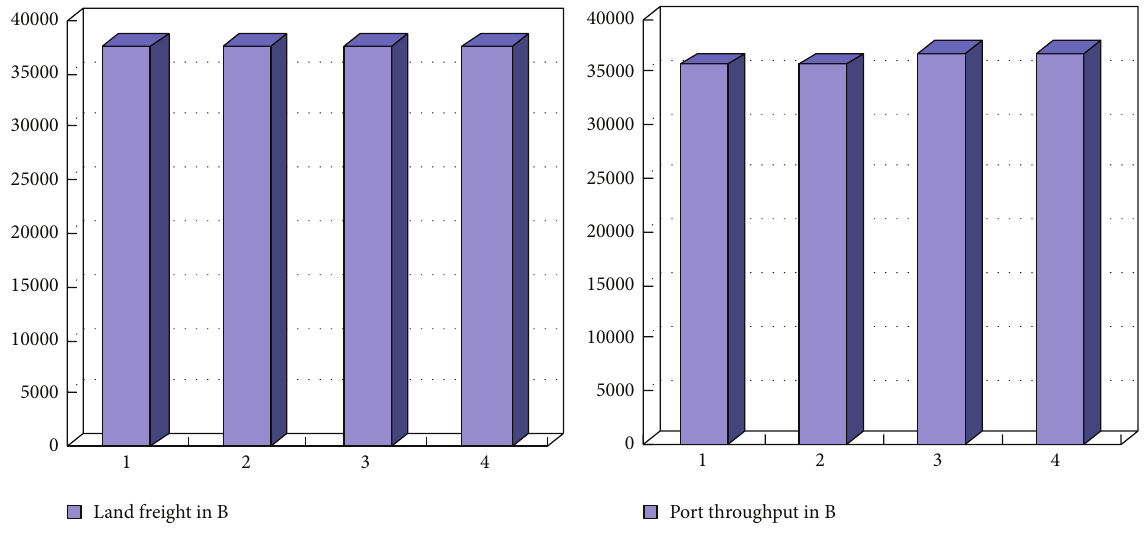
Figure 6: Freight volume of B in different